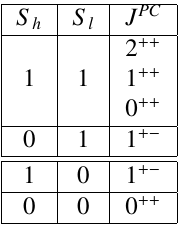
Table 1. Spectrum of L = 0 states of two heavy and two light